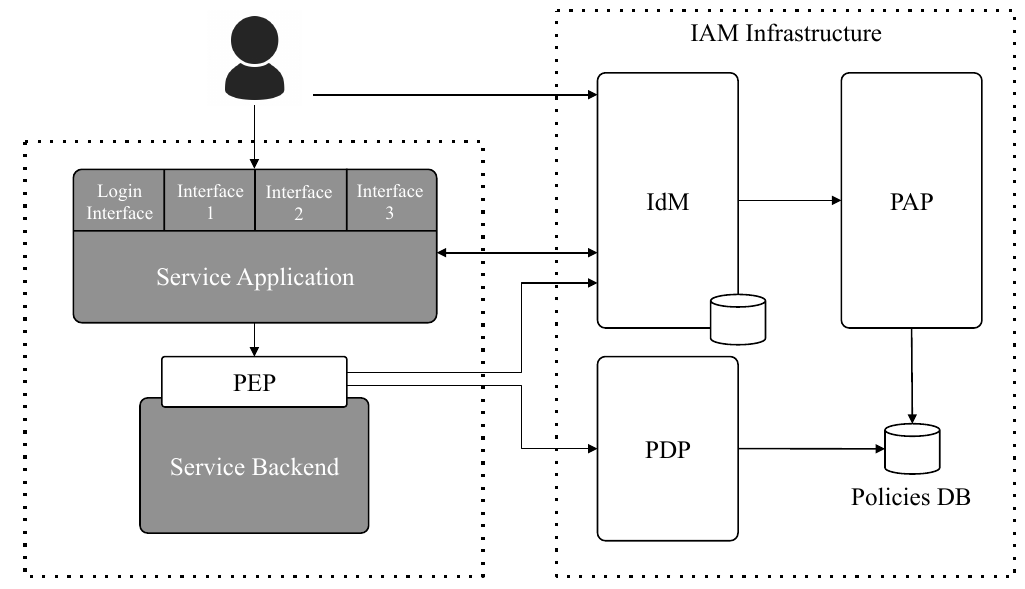
Figure 3. Advanced architecture with access